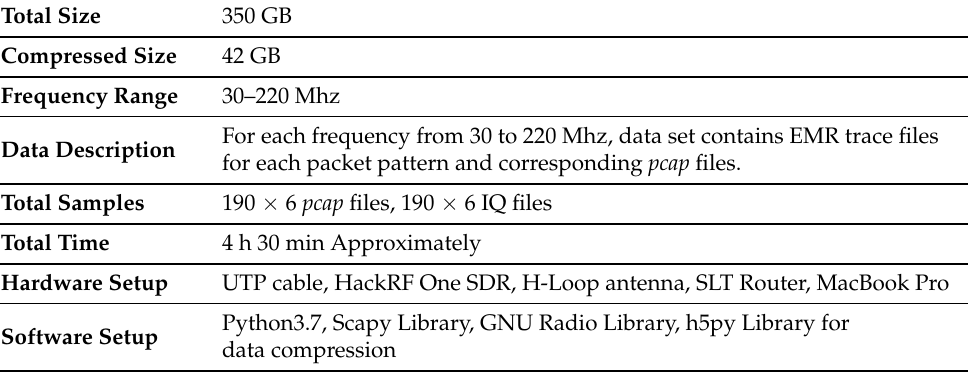
Table 2. EMR data set